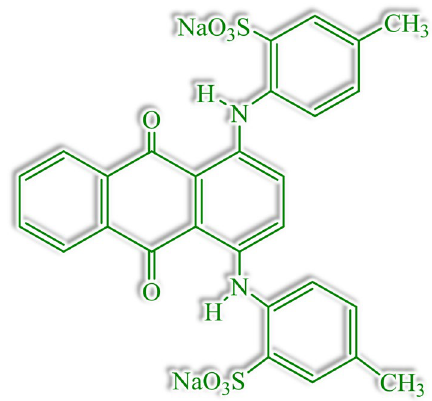
Figure 1. Chemical structure of AG-25